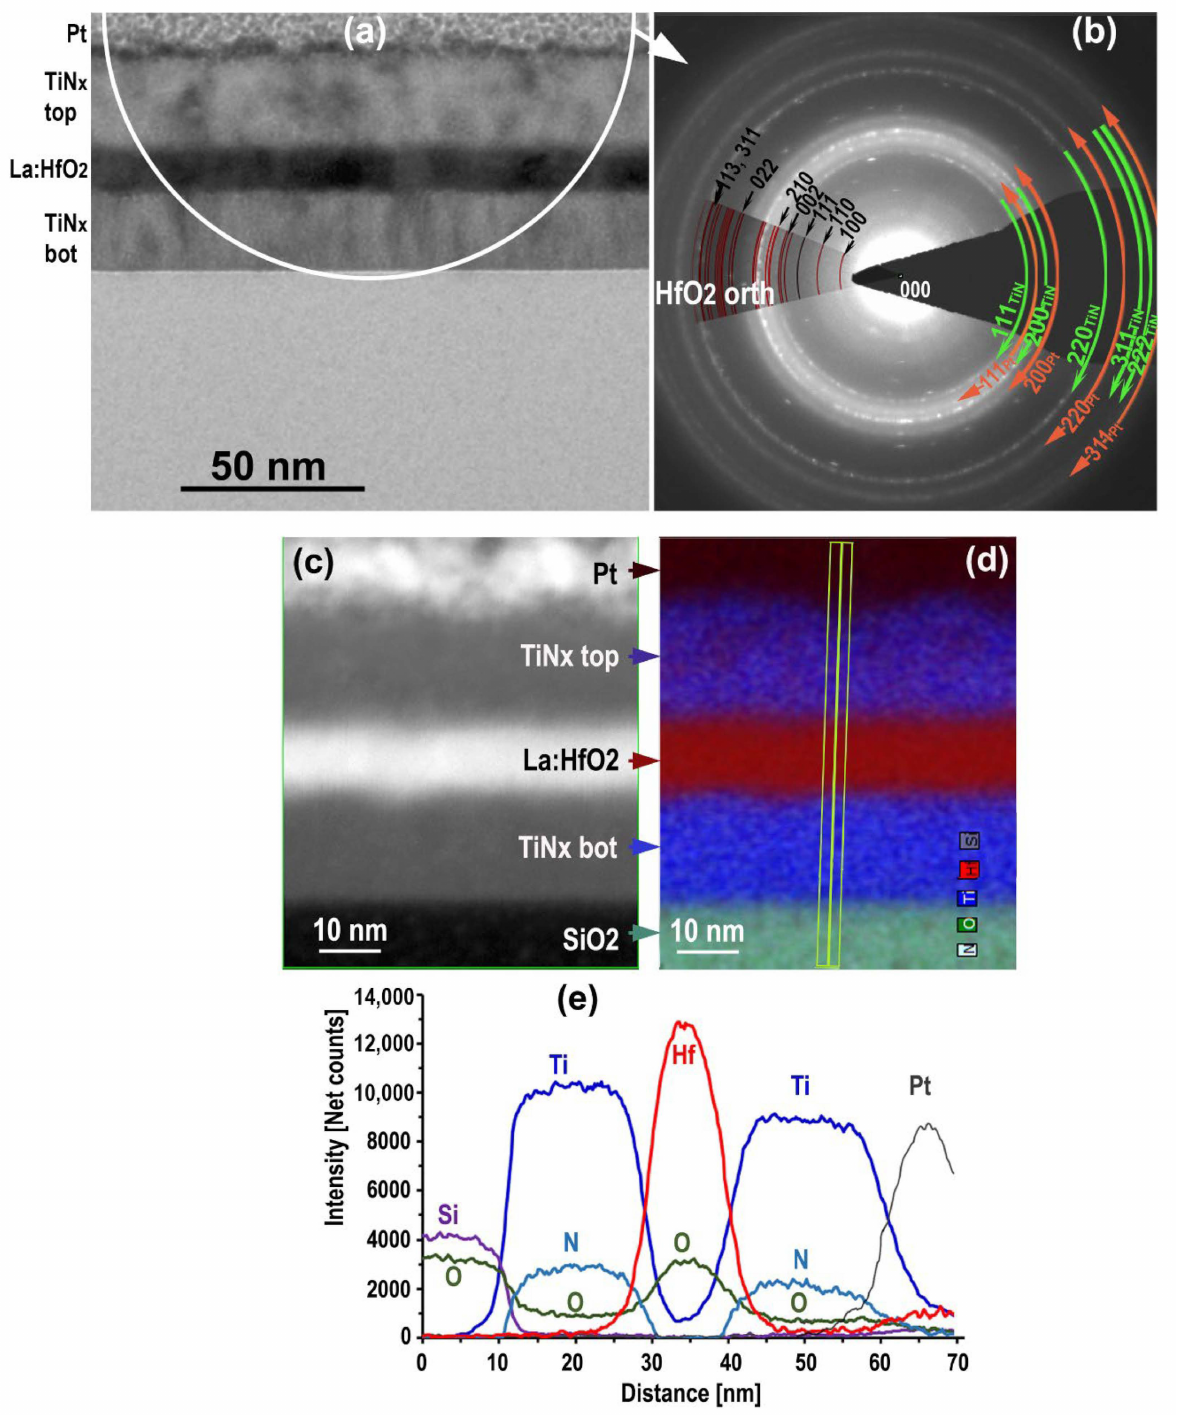
Figure 1. MIM structure on SiO 2 : Overall view of TEM bright field cross section ( a ), SAED pattern taken from the area highlighted contains labelled reflections from cubic TiN, Pt and nanocrystalline orthorhombic hafnium oxide ( b ); HAADF STEM image ( c ) and the corresponding EDXS element map with transverse line scan ( d ), Ti, N and O net counts profiles along the transverse line scan ( e